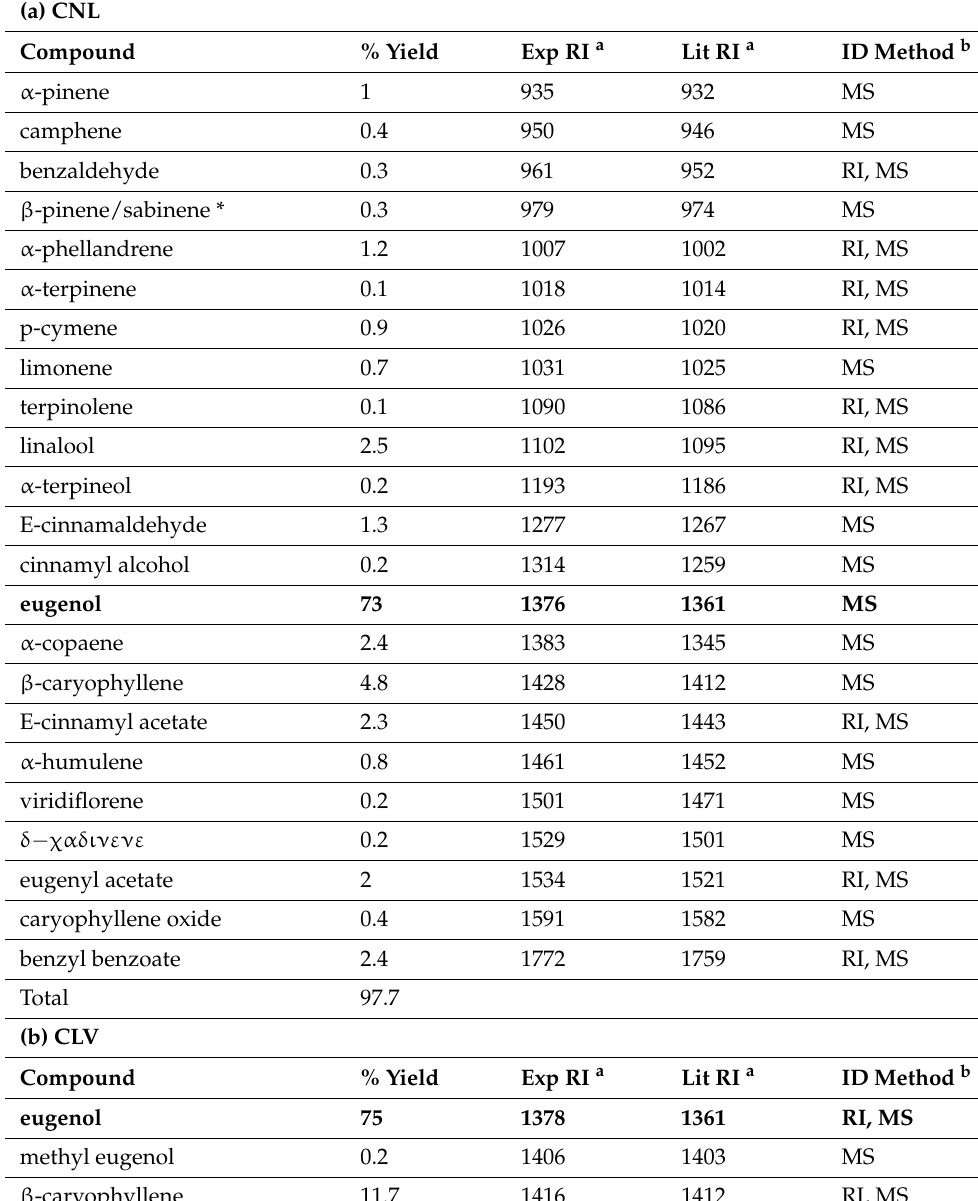
Table 1. Chemical composition of essential oils (major component in